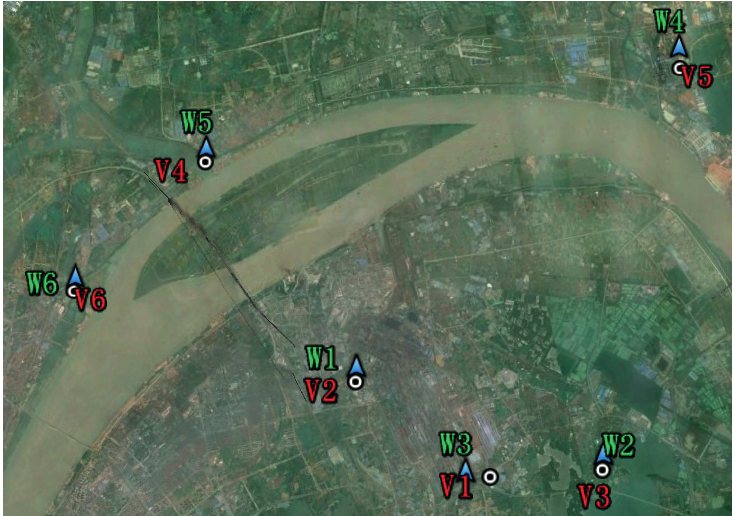
Figure 4. Distributions of six sites in an image of Wuhan acquired by satellite. The blue triangle with green labels represents the ESDD monitoring site, while the white annulus with red labels represents the verification point. The dimensions of the area shown in Figure 4 are roughly 10 km by 10